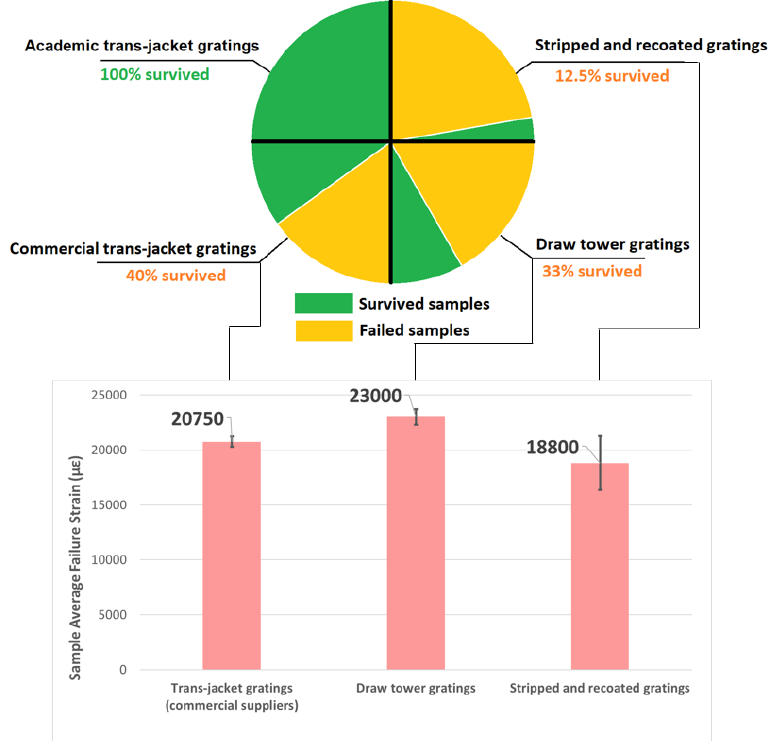
Figure 5. Summary of fatigue performance of FBG sensors, including average strain to failure and survival rates (error bars show the standard deviation of the failure strain results).